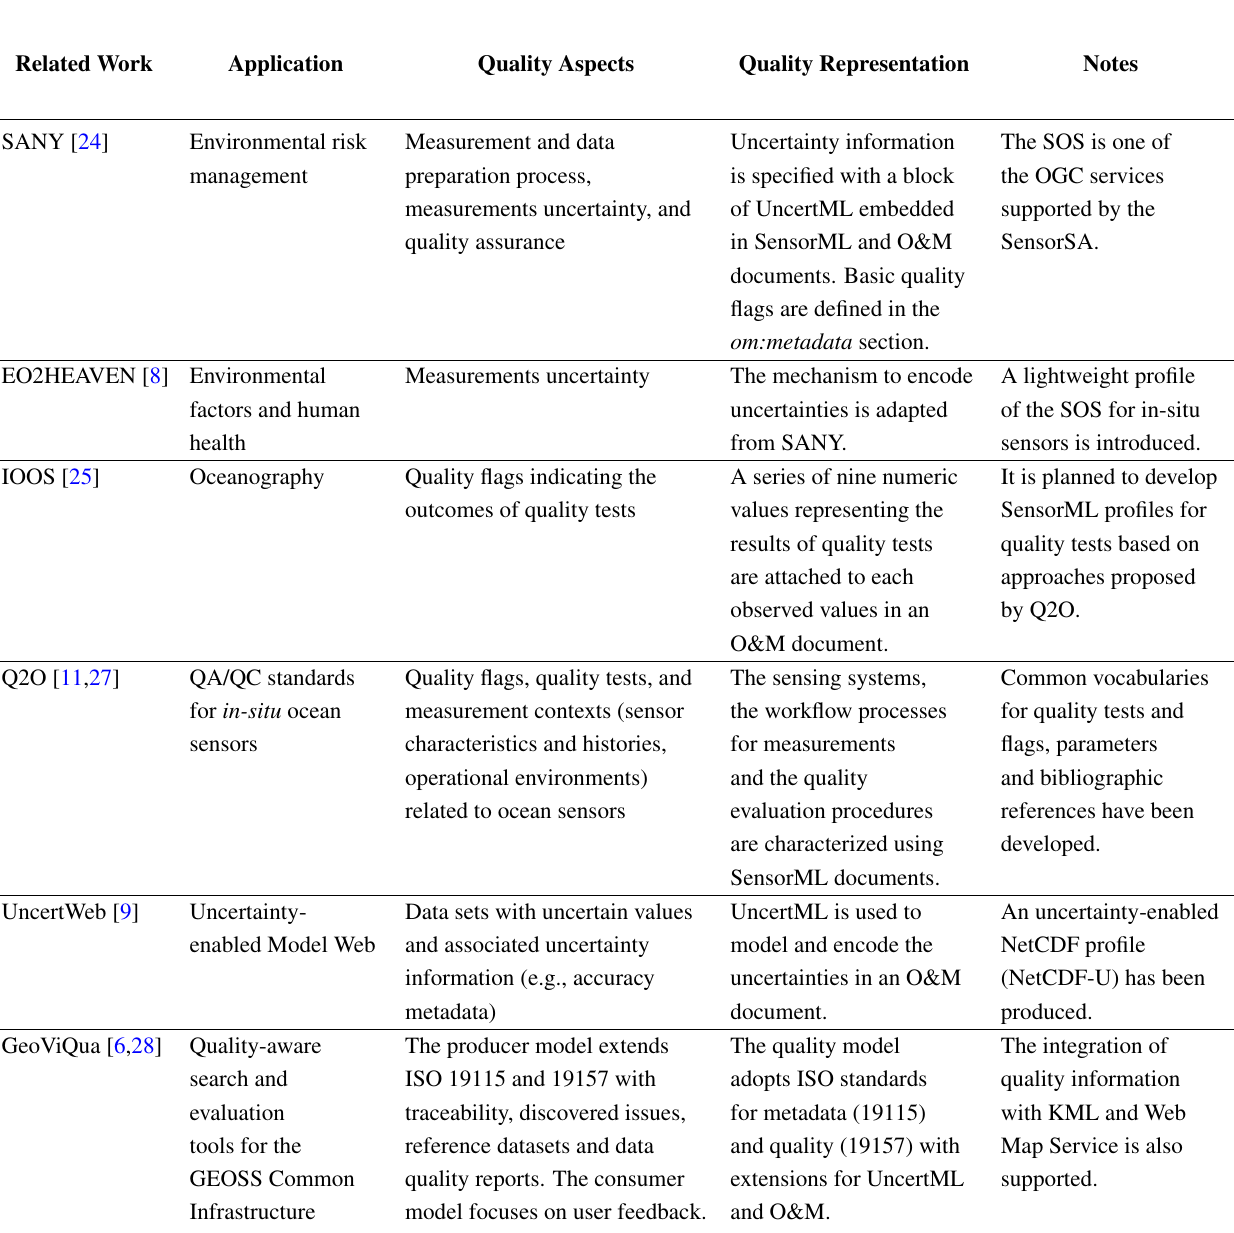
Table 1. Related work on integrating quality information into the Sensor